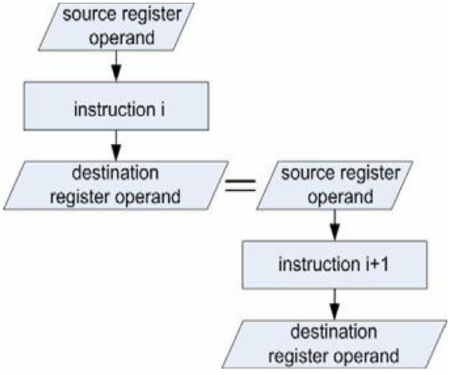
Figure 1. The principle of instruction